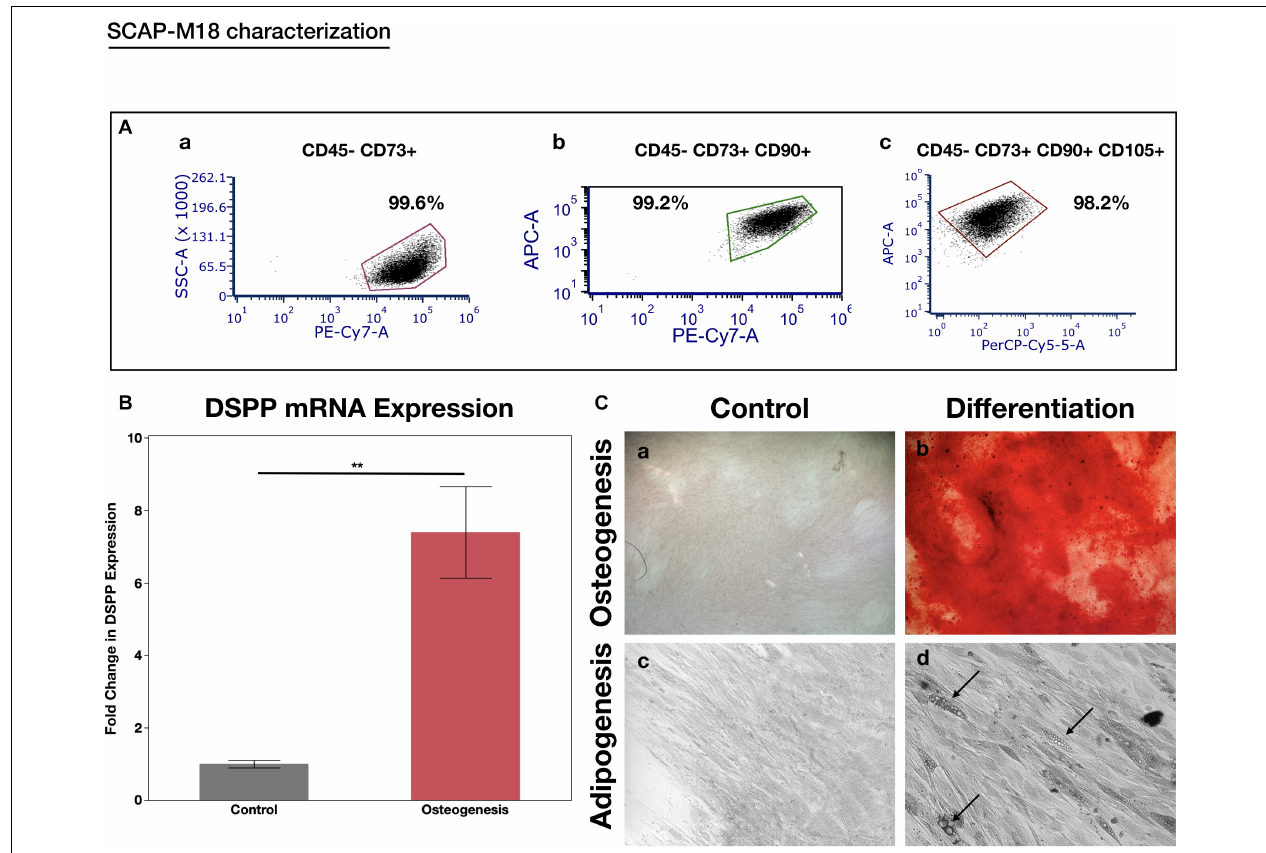
FIGURE 2 | SCAP cell line characterization. (A) Flow cytometry expression of the MSC markers in the CD45- population: (a) CD73, (b) CD73 co-expression with CD90, and (c) co-expression of CD73, CD90, and CD105. More than 98% of the cells formed a cell niche and expressed all three stem cell markers while being negative for the endothelial marker CD45-, indicating their stemness. (B) RT-PCR analysis of DSPP gene after inducing the cells with osteogenesis media for 14 days. There was a significant 7-fold increase in DSPP expression after osteogenic induction. ** p < 0.05. (C) Osteogenic (a,b) and Adipogenic (c,d) induction of SCAPs with light microscopy 10x. Alizaring red staining used to depict the mineralization nodules (a,b). Black arrows point to lipid droplets (d).